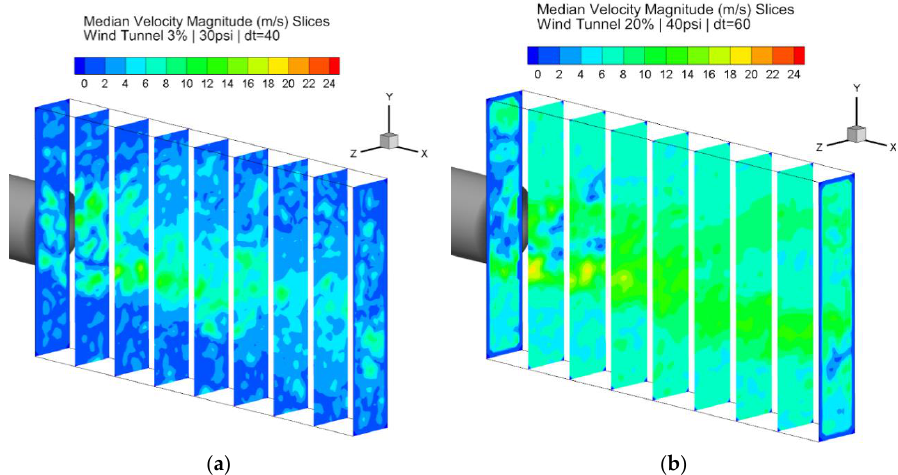
Figure 13. Instantaneous velocity vector slices for 3% freestream and 30 psi vortex settings ( a ) and 20% freestream and 40 psi settings ( b ). Fluids 2020 , 5 , x FOR PEER REVIEW